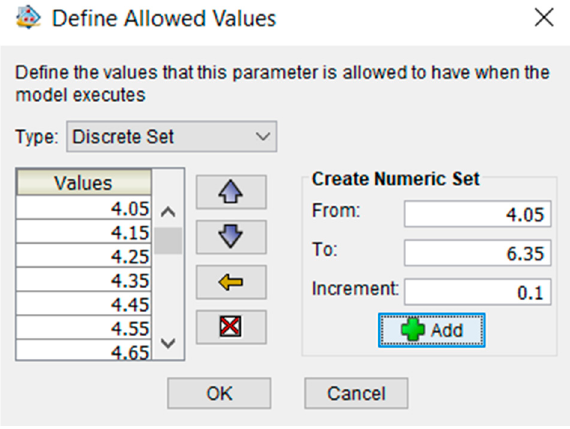
Figure 10. Defining allowed values for the SPA’s inner radius.